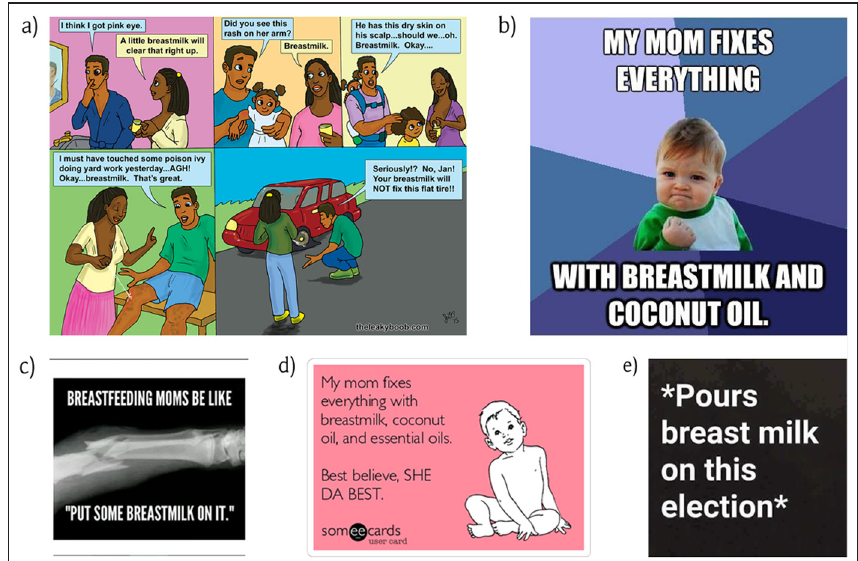
Figure 3: Spoofing breastmilk as a